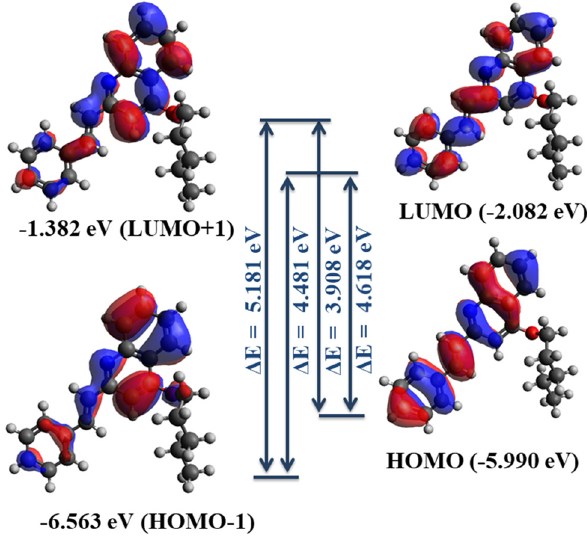
Figure 3: Molecular orbital diagram for